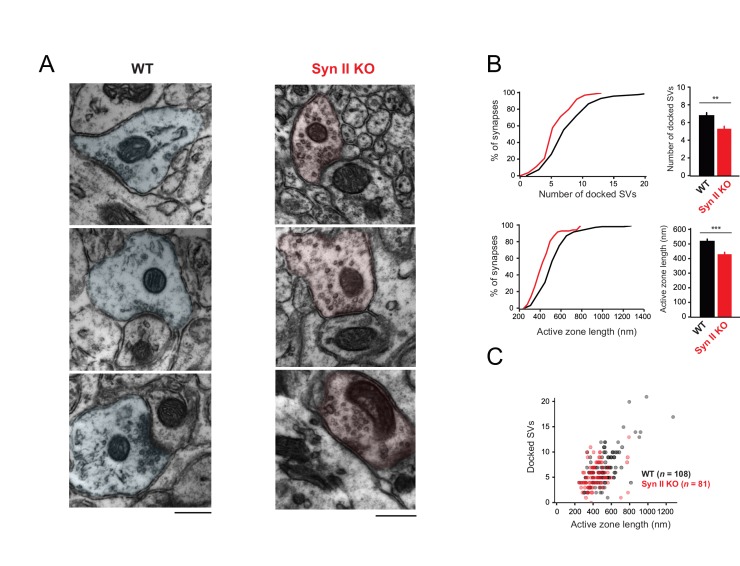
Genetic deletion of Syn II reduces the heterogeneity of ultrastructural profiles of presynaptic terminals at GC-MLI synapses.(A) Representative micrographs of GC-MLI synapses captured in the upper part of the molecular layer of cerebellar parasagittal sections from WT and Syn II KO mice. (B) Upper panels, Cumulative distribution (left panel) and mean values of the number of docked SVs at GC-MLI synapses from WT and Syn II KO mice (black line/bar and red line/bar respectively). Lower panels, similar representations for the active zone length. Absence of Syn II reduced significantly the number of docked synaptic vesicles and the length of the active zone (mean number of docked synaptic vesicles: WT 6.83 ± 0.35, n = 108; Syn II KO 5.36 ± 0.28, n = 81, mean length of active zone: WT 521.3 nm ± 15.2, n = 108; Syn II KO 432.2 nm ± 13.2, n = 81). (C) Scatter plot of the number of docked synaptic vesicles (SVs) versus the active zone (AZ) length from dataset obtained in B. Genetic deletion of Syn II led to a specific loss of GC bouton endowed with both a long active zone (>800 nm) and high number of docked synaptic vesicles (>15 synaptic vesicles).